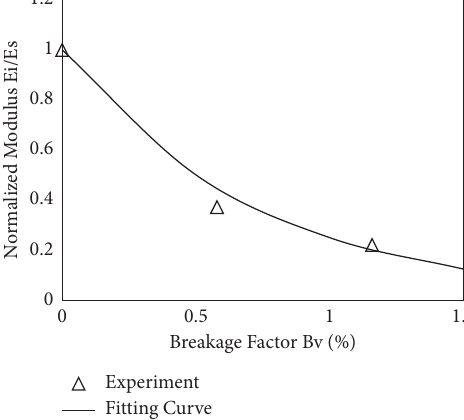
Figure 13: Plot of E